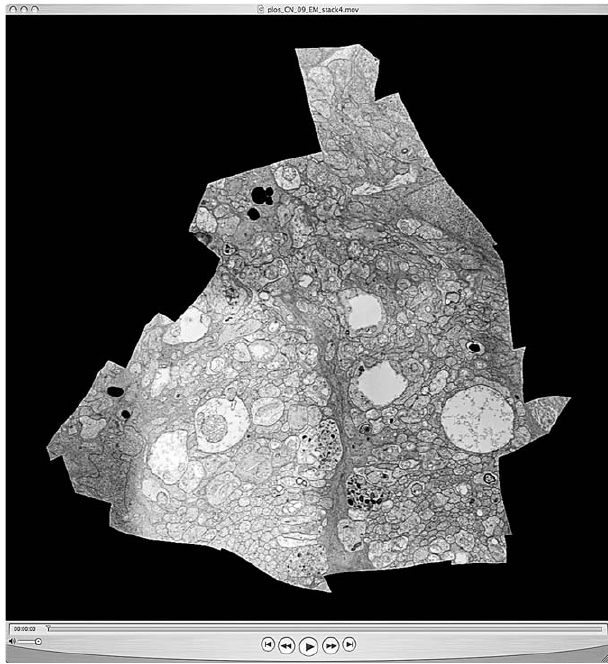
Figure 9. A Frame from a QuickTime Movie of a Volume Slice through a Mouse Retinal Microneuroma The microneuroma is 27 l m long and 16 l m wide at mid-length. The volume slice spans 45 sections, 90 nm each for a thickness of 4 l m. The original data were scanned from manually acquired TEM film images, aligned using ir-stos tools, and converted to a smaller movie using ir- stom (slice-to-movie), which generates 90 frames. Each slice is cropped such that only pixels with valid mapping onto every slice in the volume are kept. The raw serial image output from ir-stom was imported into QuickTime Pro v7 and saved as a movie. See Video